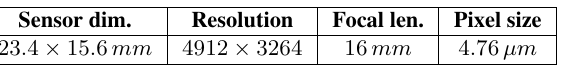
Table 1: Camera and sensor